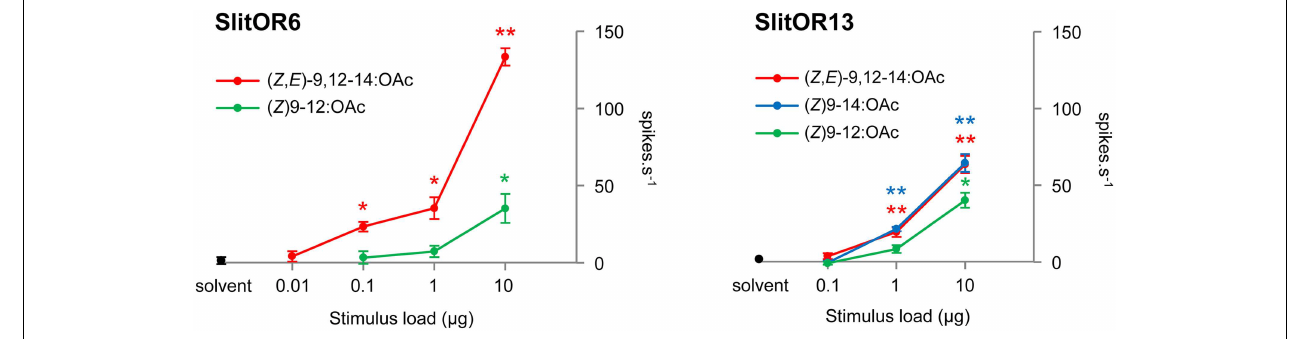
the stimulus cartridge. Error bars indicate SEM ( n = 5 ). ** P < 0 . 001 , * P < 0 . 01 significantly different from the response to solvent (Mann-Whitney U -test).